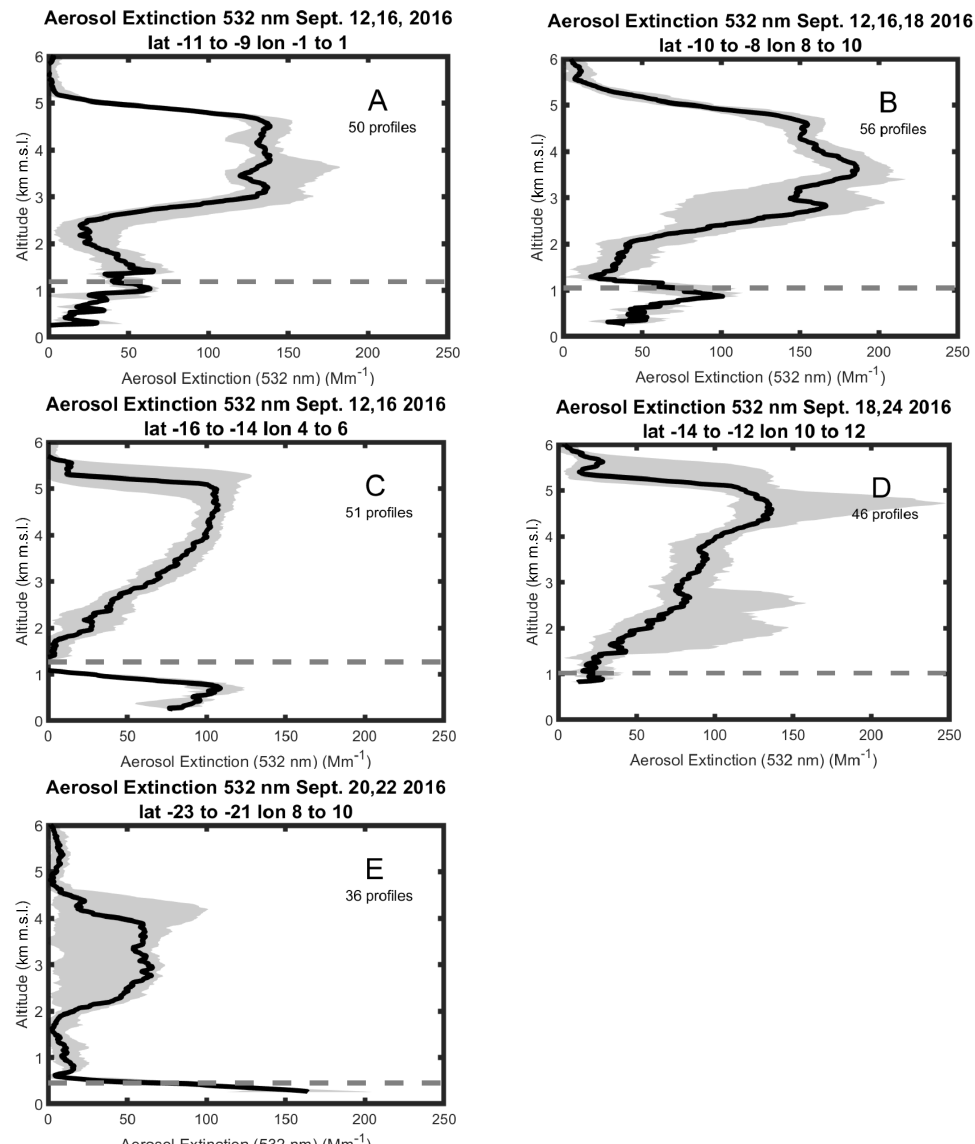
Figure 6. Average vertical profiles of the aerosol extinction coefficient at 532nm in grid boxes A (upper left), B (upper right), C (middle left), D (middle right), and E (lower left). The averaging area, dates of flights, and total number of 1min profiles are also shown. The dark line represents the median value and gray shades contain the 25th to 75th percentiles. Dashed line refers to the mean cloud top